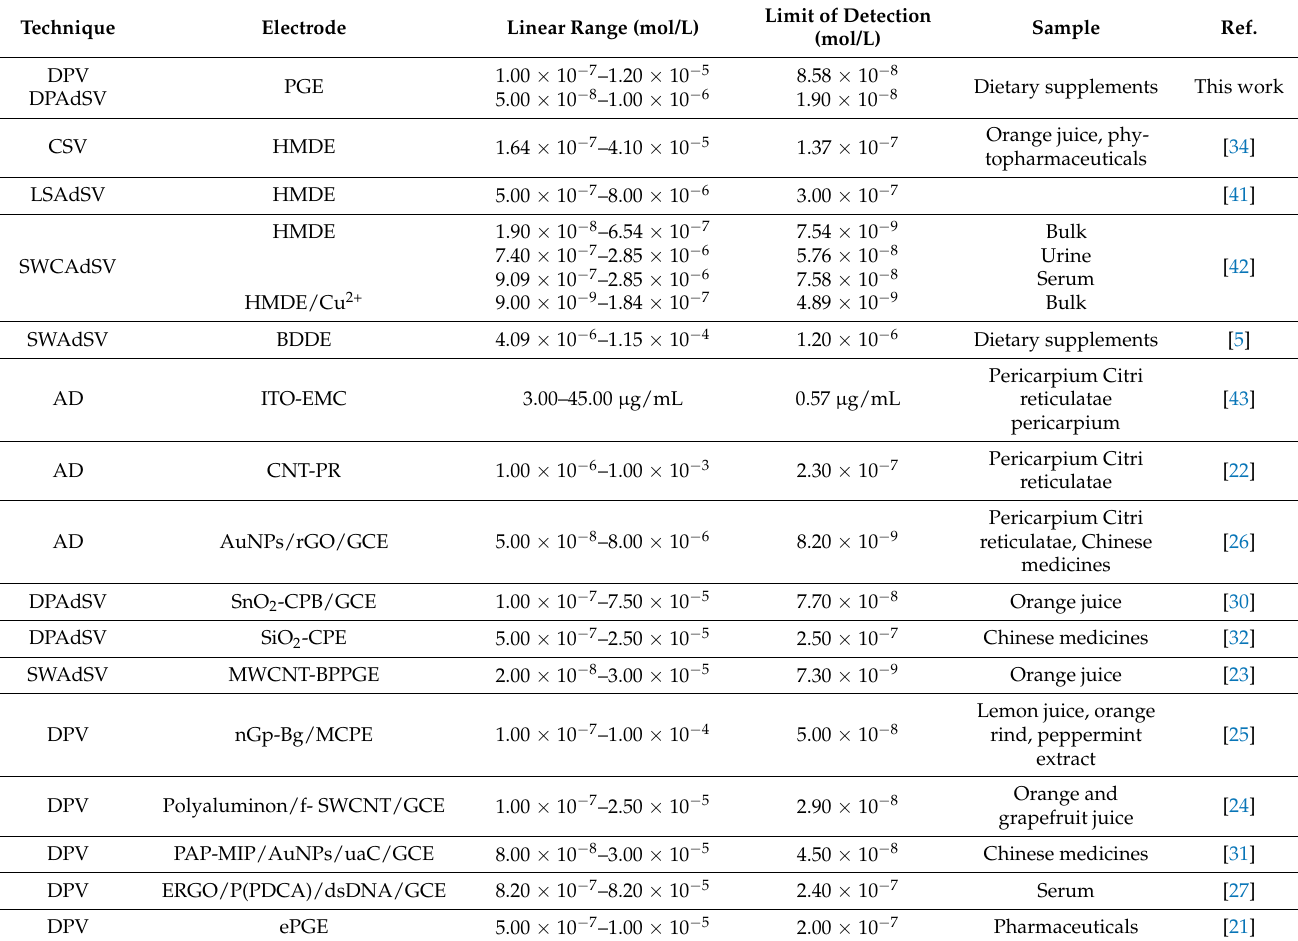
Table 3. The performance characteristics of voltammetric methods reported in the literature for hesperidin determination. Technique